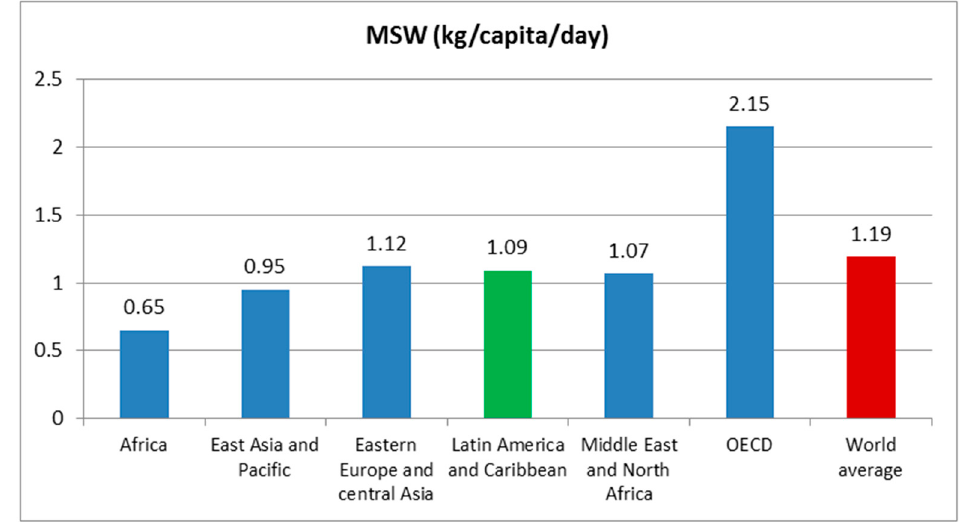
Figure 1. MSW generation (kg/capita/day) by various regions in the world [1].